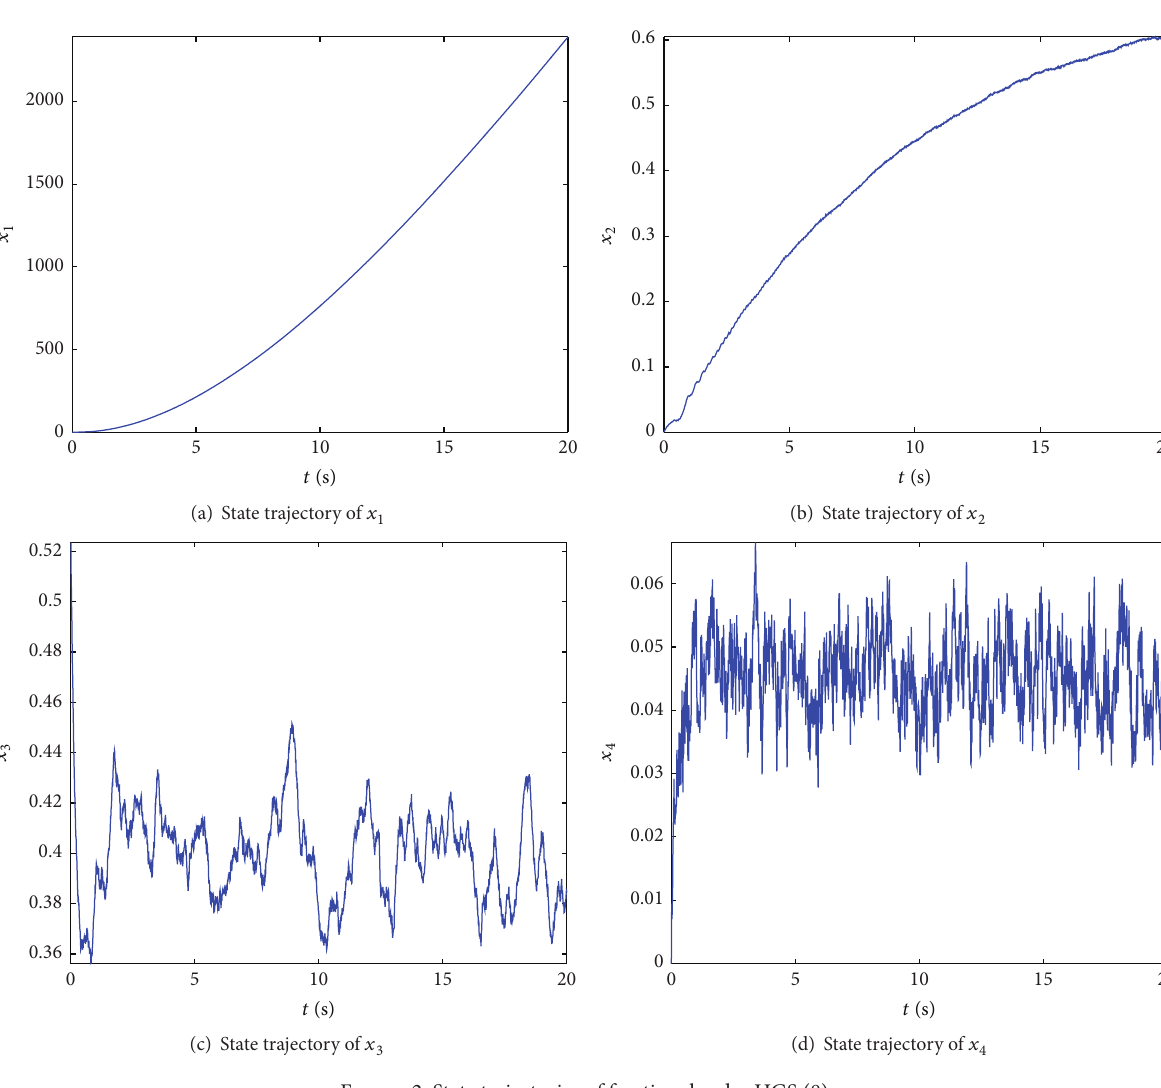
Figure 2: State trajectories of fractional order HGS